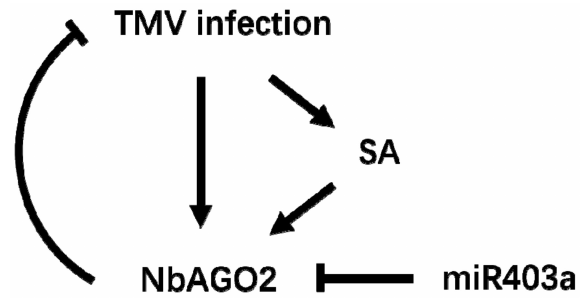
Figure8. Modelfor NbAGO2 mediatedantiviraldefensesagainstTMVinfectionin Nicotianabenthamiana